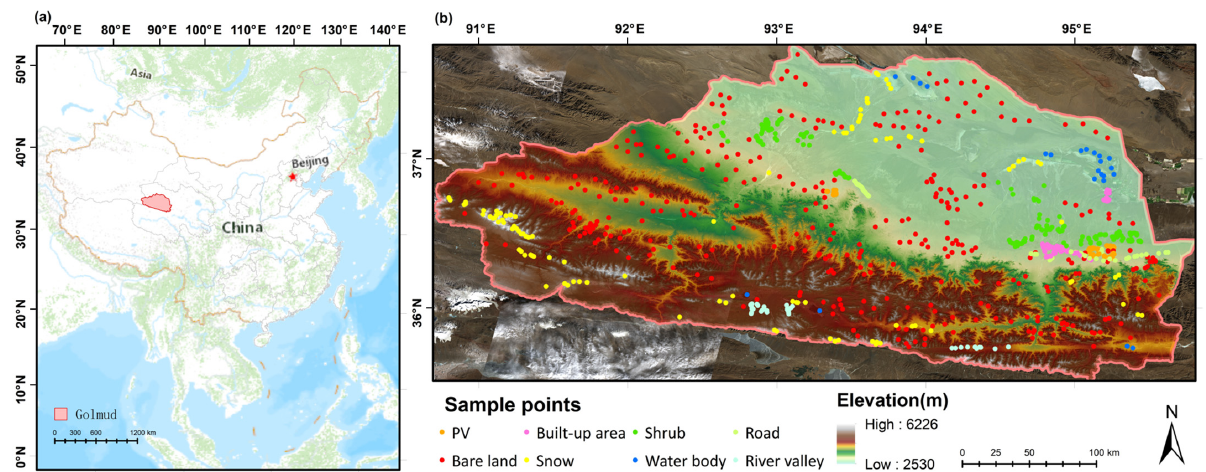
Figure 1. Maps showing ( a ) the location of the study area and ( b ) a sample of the land cover classes.